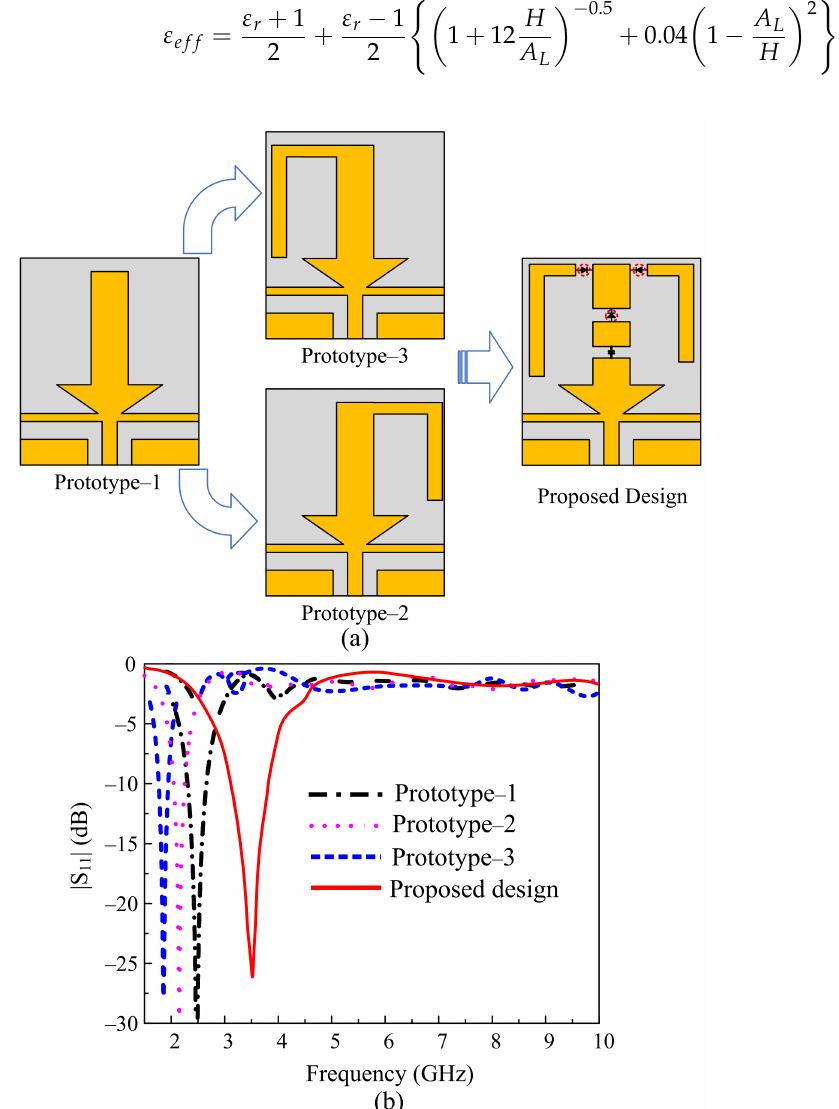
Figure 5. The steps involved in designing the proposed filtenna. ( a ) Geometrical configuration and ( b ) their |S 11 |